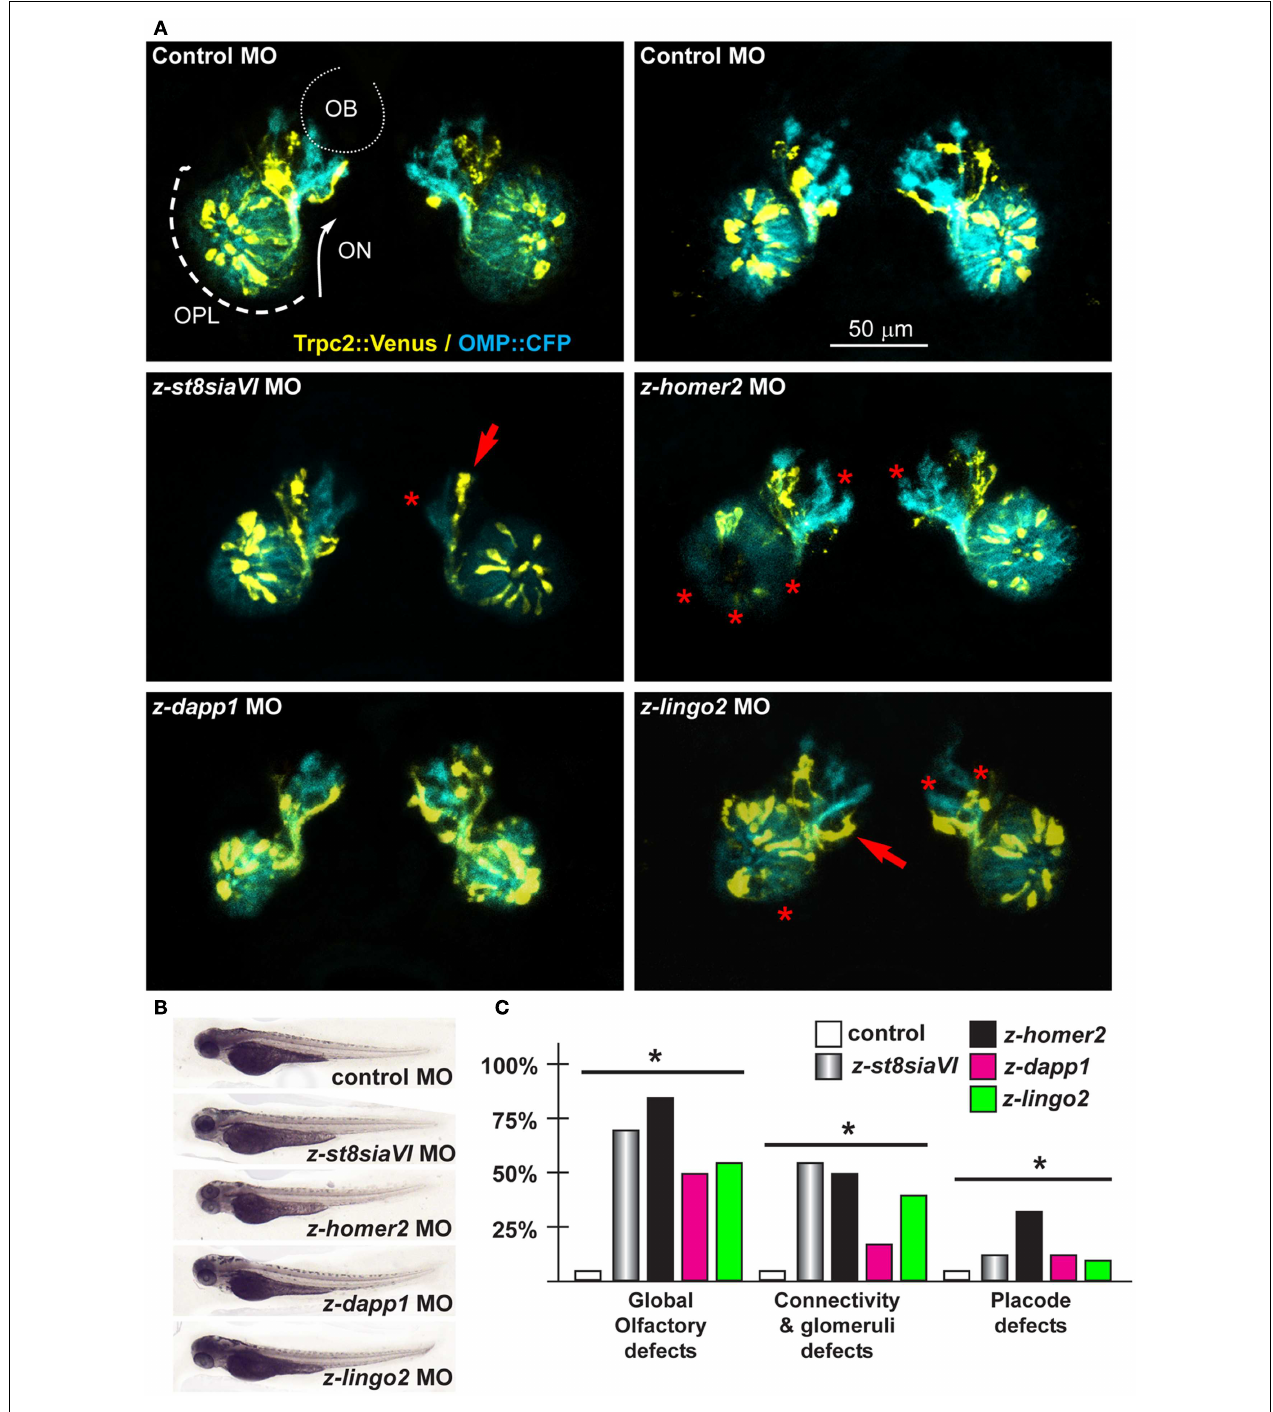
absence of glomeruli or altered OPL organization. Asterisks indicate the regions of reduced fluorescence intensity. (B) Whole-mount bright field micrographs of injected embryo, showing normal morphology and growth rate. (C) Proportions of embryos showing either placode defects, connectivity and glomeruli defects, or both, upon injection of the MOs indicated above (colored bars), compared to control MO (open bars). Asterisks indicate statistical